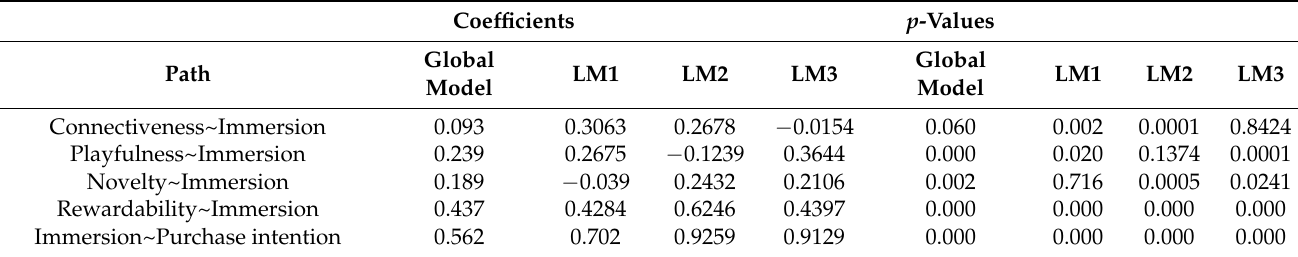
Table 3. REBUS-PLS